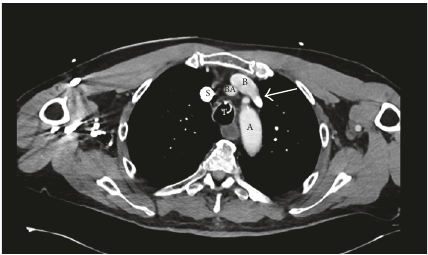
Figure 2: Cross section CTA of chest. S = superior vena cave, B = innominate vein, BA = innominate artery, T = trachea, and A = aorta. Arrow points to the insertion of aberrant left superior pulmonary vein into innominate